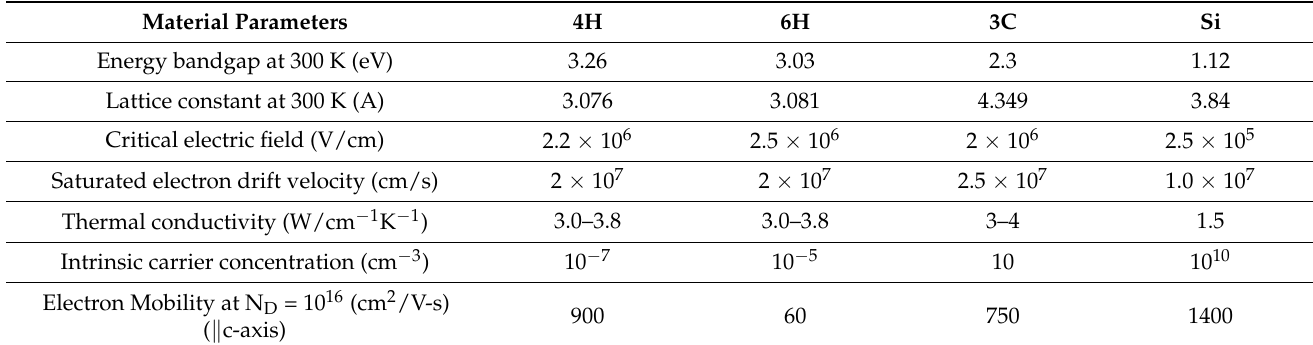
Table 1. Comparison of material parameters of polytypes of SiC and Si